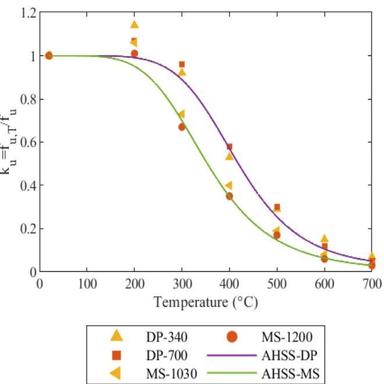
Comparison of proposed retention factors for ultimate stress with test data.